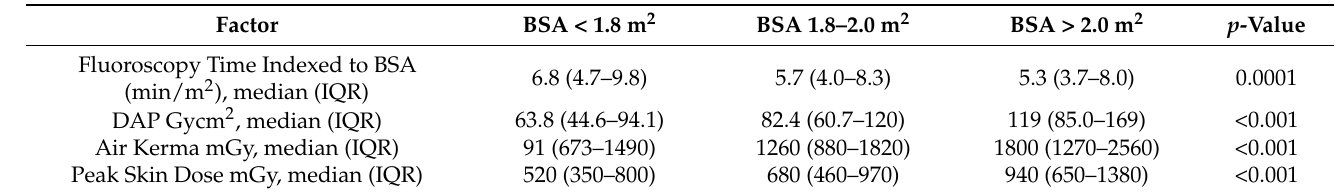
Table 4. Radiation measures for PCI cohort, including indexed fluoroscopy time, dose–area product, air kerma and peak skin